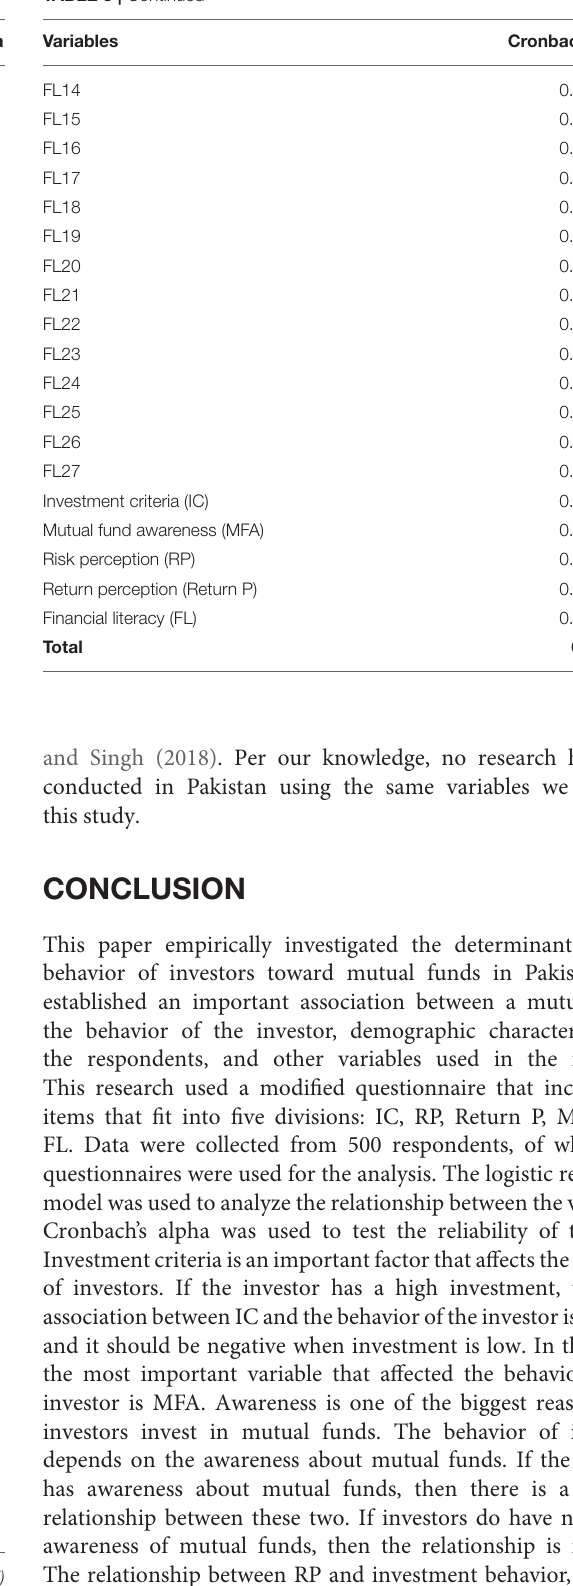
TABLE 3 | Reliability